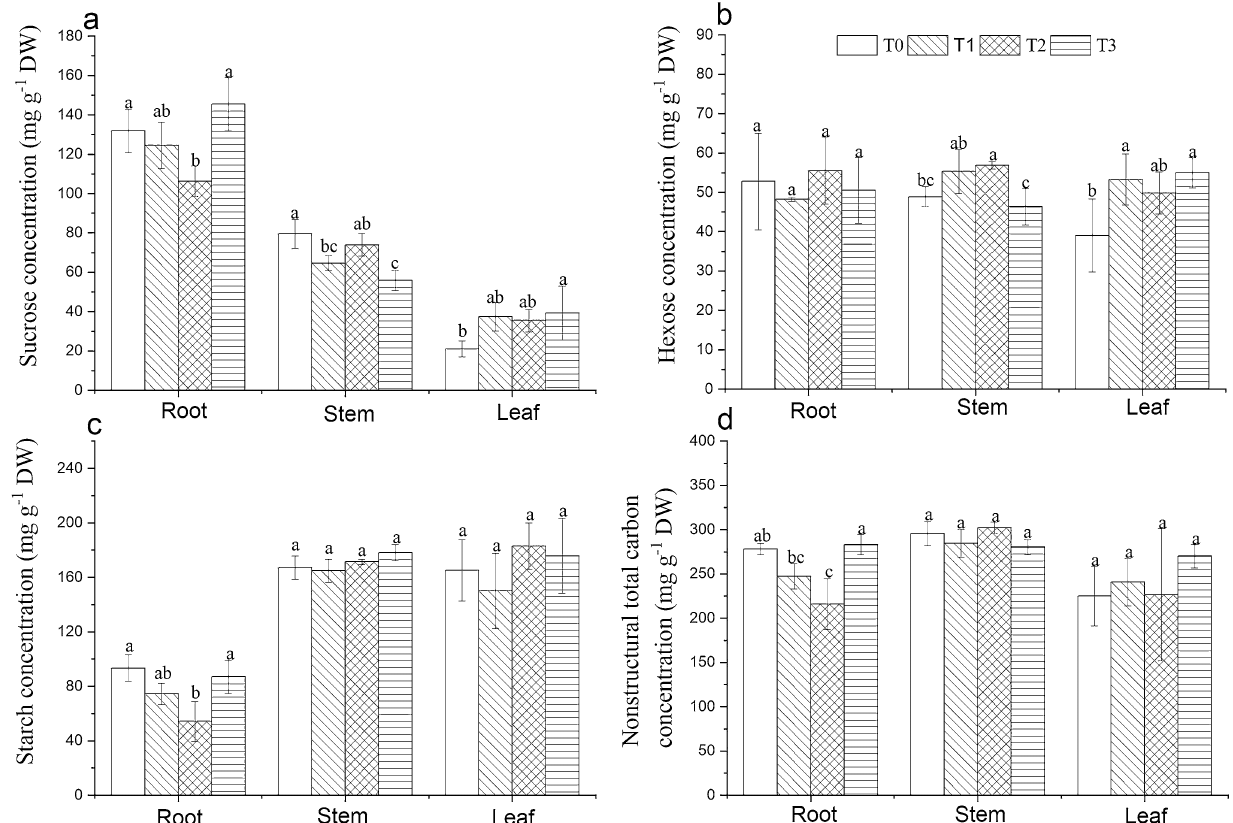
Figure 1. Effects of the mixtures of red soil and rice husk ash with various proportions on the sucrose ( a ), hexose ( b ), starch ( c ) and total nonstructural carbohydrate ( d ) concentrations in the root, stem and leaf of cotton seedlings. Histograms denote means ± SD, and diverse letters over which indicate significant difference at P ≤ 0.05 level. T0, T1, T2, and T3 represent the mixture of red soil to RHA at volume ratios of 1:0, 1:1, 2:1, and 1:2,